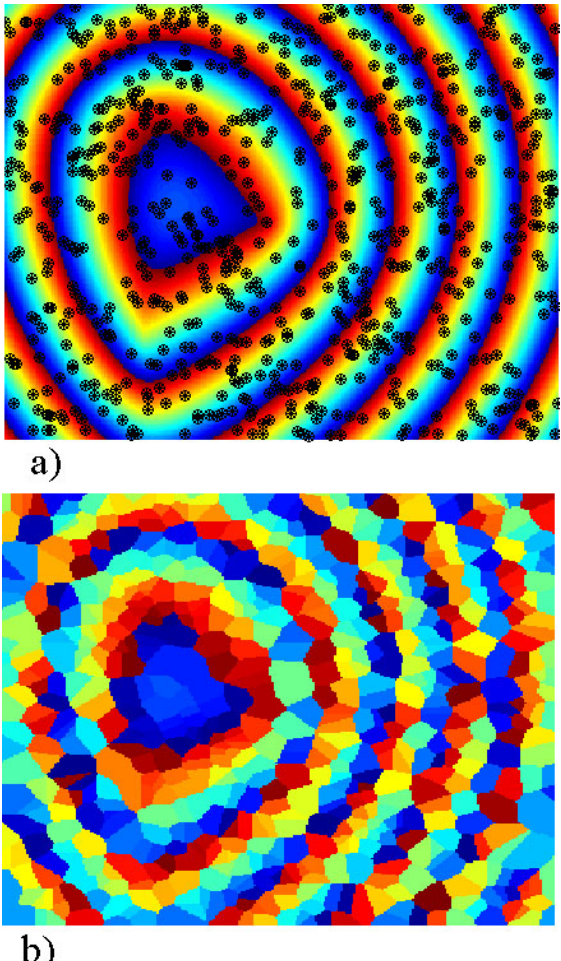
An irregular space which is constructed by random selection of figure1.b pixels and the 2_D continuous interferogram interpolated with nearest neighbor method are presented in figure 2.a and 2.b, respectively.